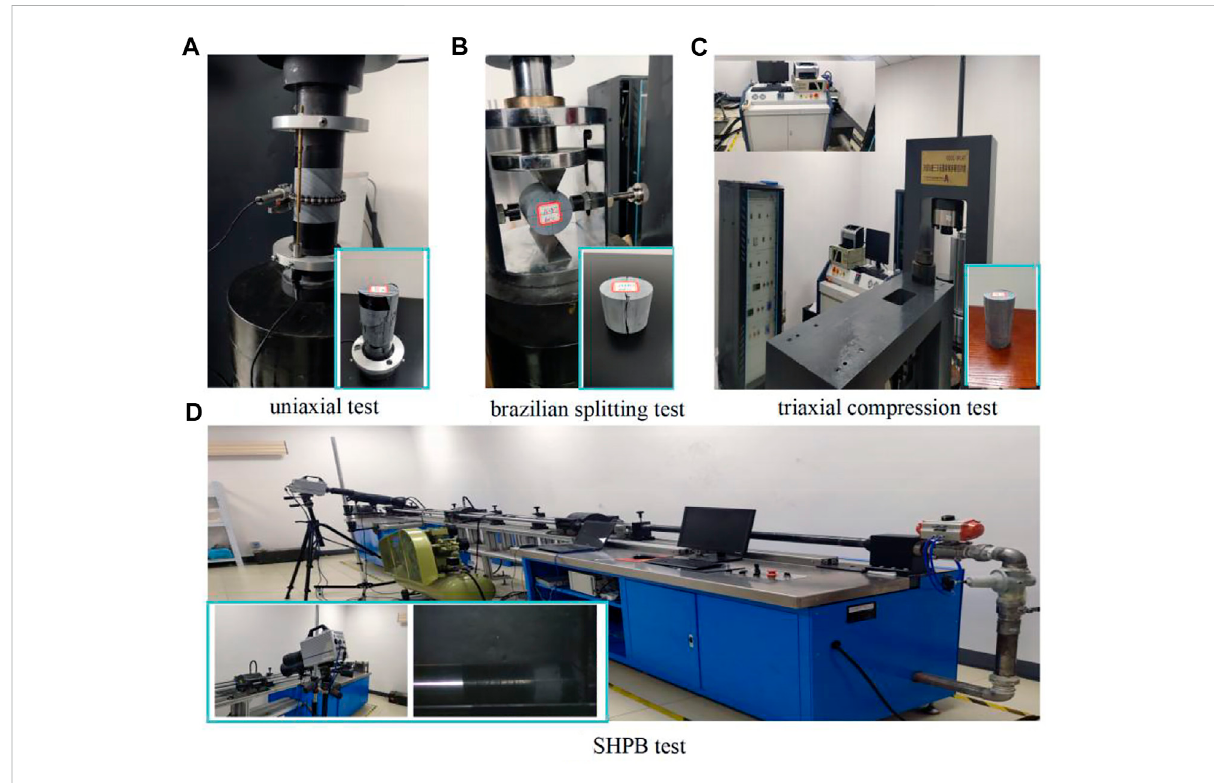
FIGURE 3 Mechanical test of slate.